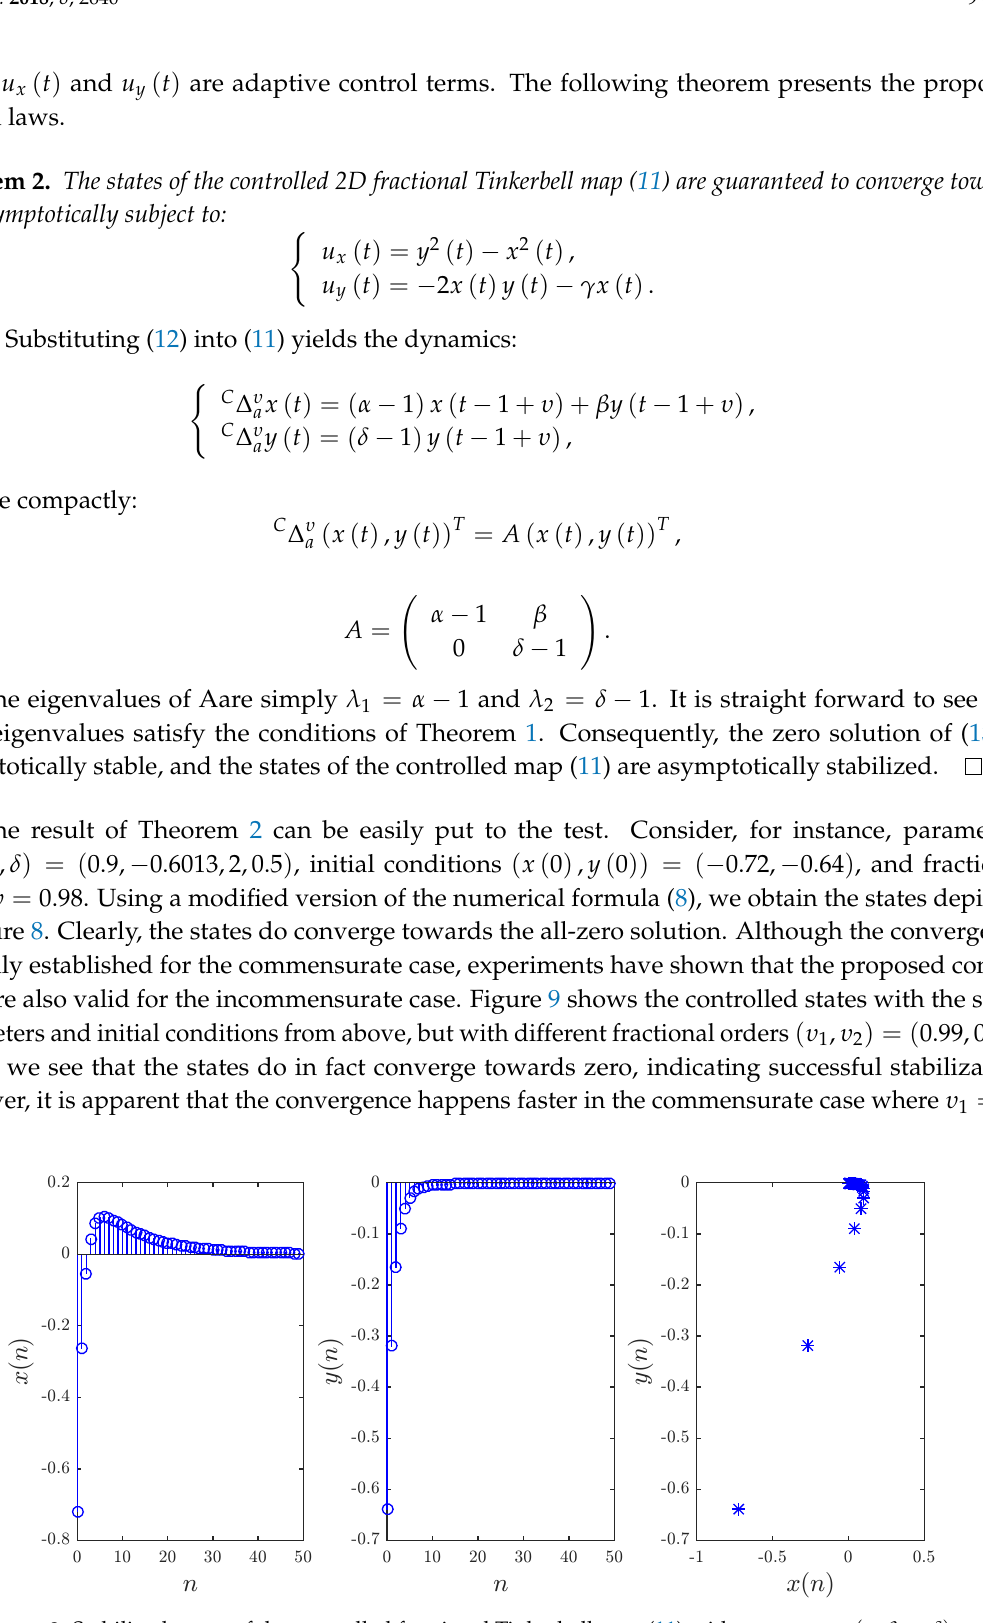
Figure 8. Stabilized states of the controlled fractional Tinkerbell map (11) with parameters ( α , β , γ , δ ) = ( 0.9, − 0.6013,2,0.5 ) , initial conditions ( x ( 0 ) , y ( 0 )) = ( − 0.72, − 0.64 ) , and fractional order υ =